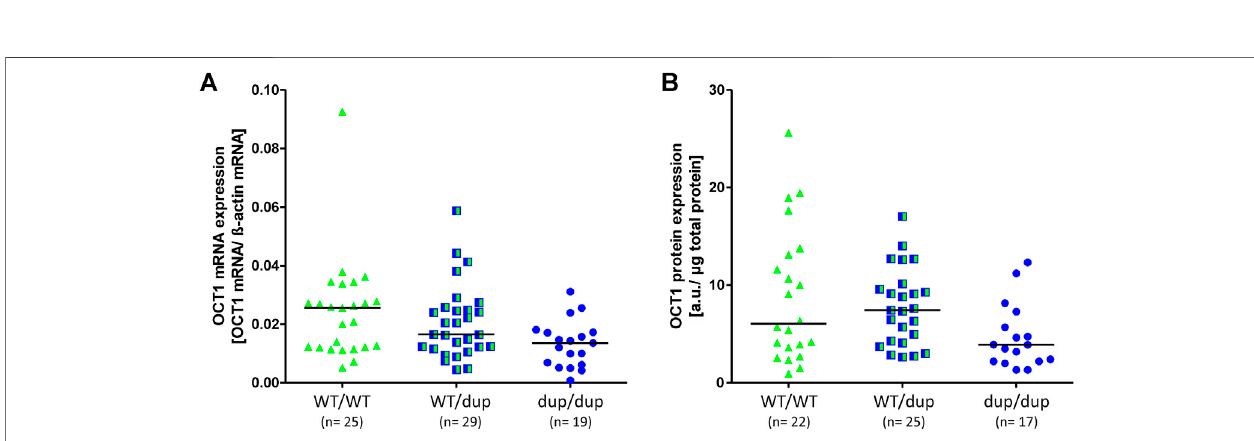
FIGURE6| Effectofrs35854239onOCT1 (A) mRNAand (B) proteinexpression. MedianOCT1 (A) mRNAexpressionand (B) protein expressionwasanalyzed in 73 liver samples depending on the rs35854239 genotype. Dup, rs35854239 duplication allele; WT, wild-type OCT1 allele; a. u., arbitrary unit.